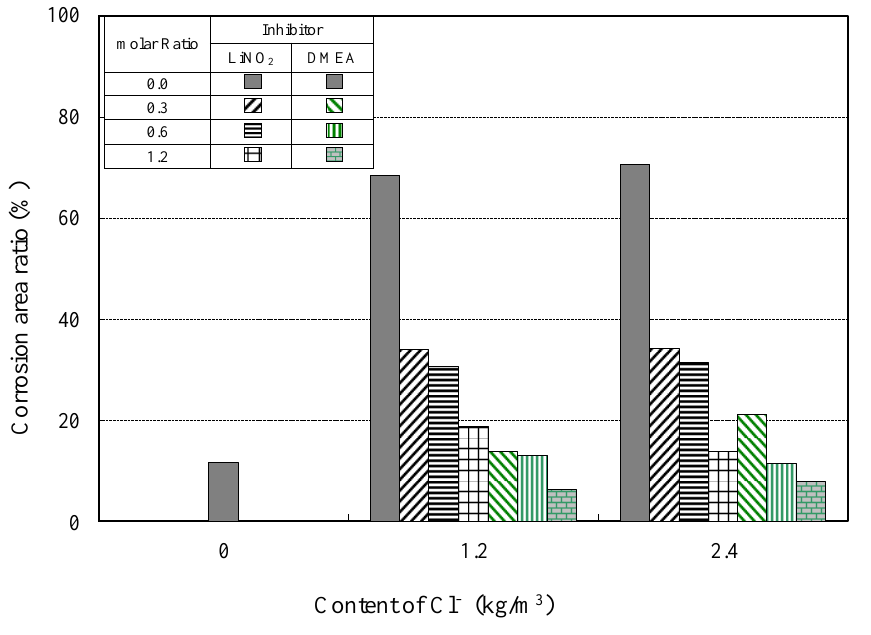
Figure 12. Corrosion/area ratio at various molar ratios of